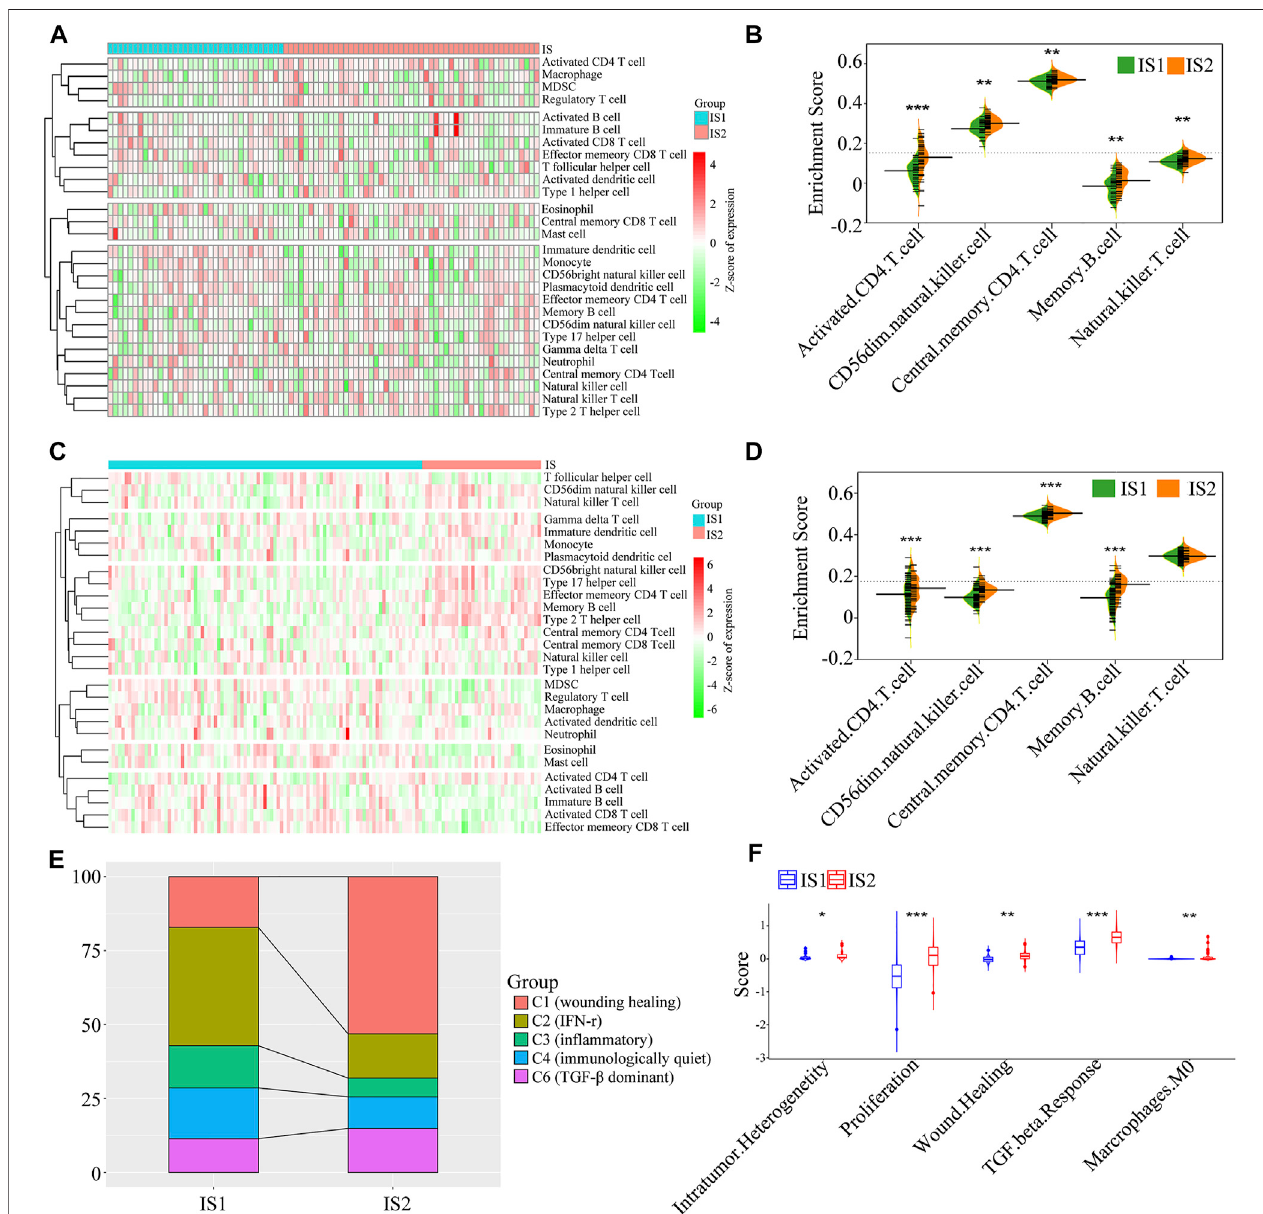
FIGURE 7 | The cellular and molecular features of the two immune subtypes. The difference in the enrichment scores of immune cells between the two immune subtypes from the TCGA cohort (A,B) and GEO cohort (C,D) (E) The distribution of fi ve pan-cancer immune subtypes in the mesothelioma immune subtypes (F) The difference in the enrichment scores of immune signatures between the two immune subtypes (* p < 0.01, ** p < 0.001, and, *** p < 0.0001).